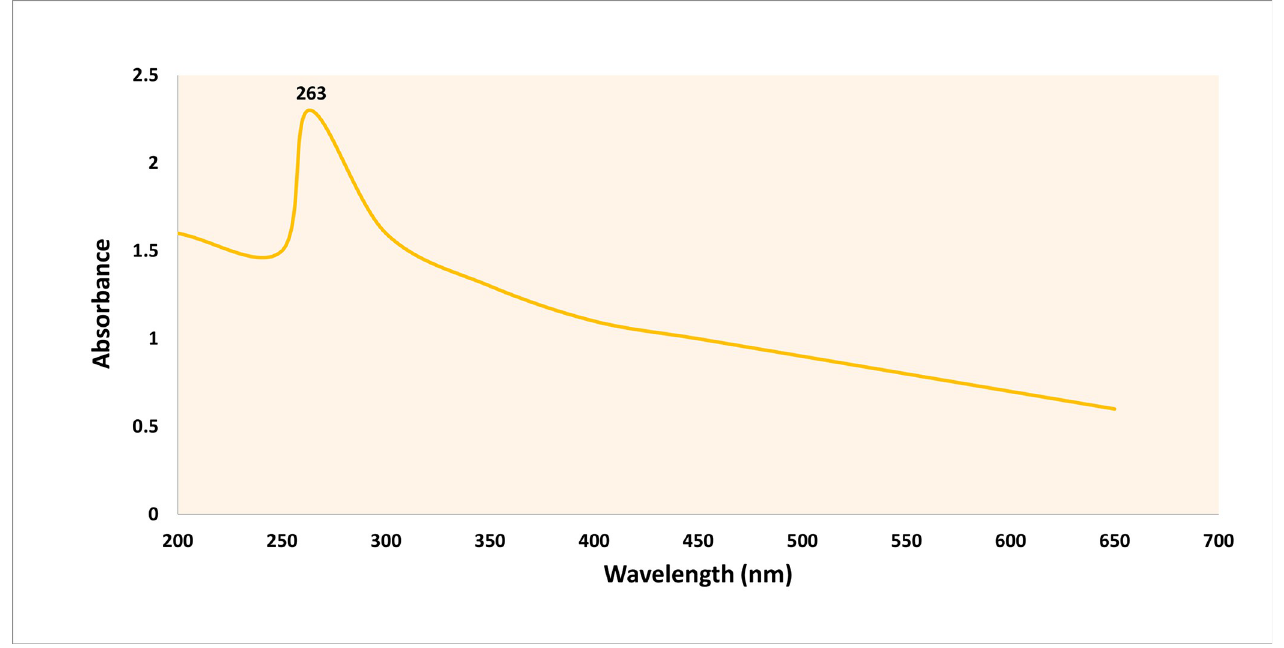
Fig 1. UV–visible spectrum of the green synthesized selenium nanoparticles